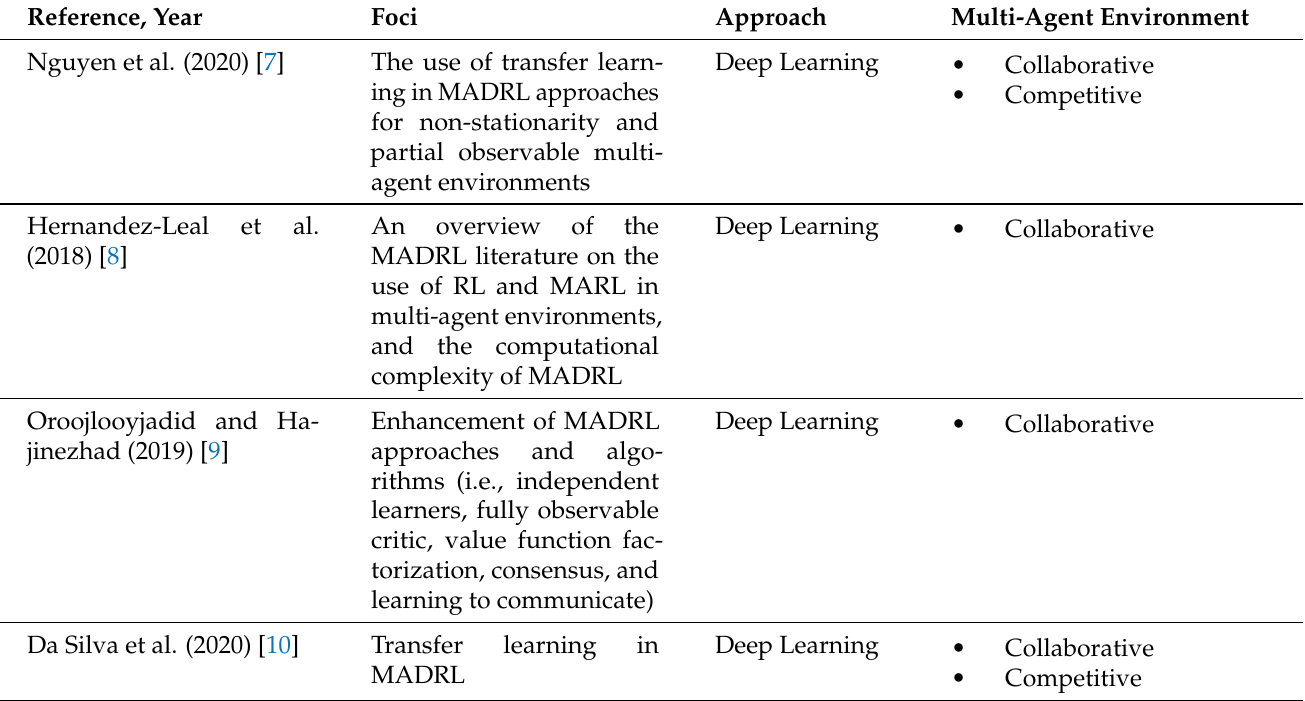
Table 1. Summary of the foci, approaches, and targeted multi-agent environments of recent and our